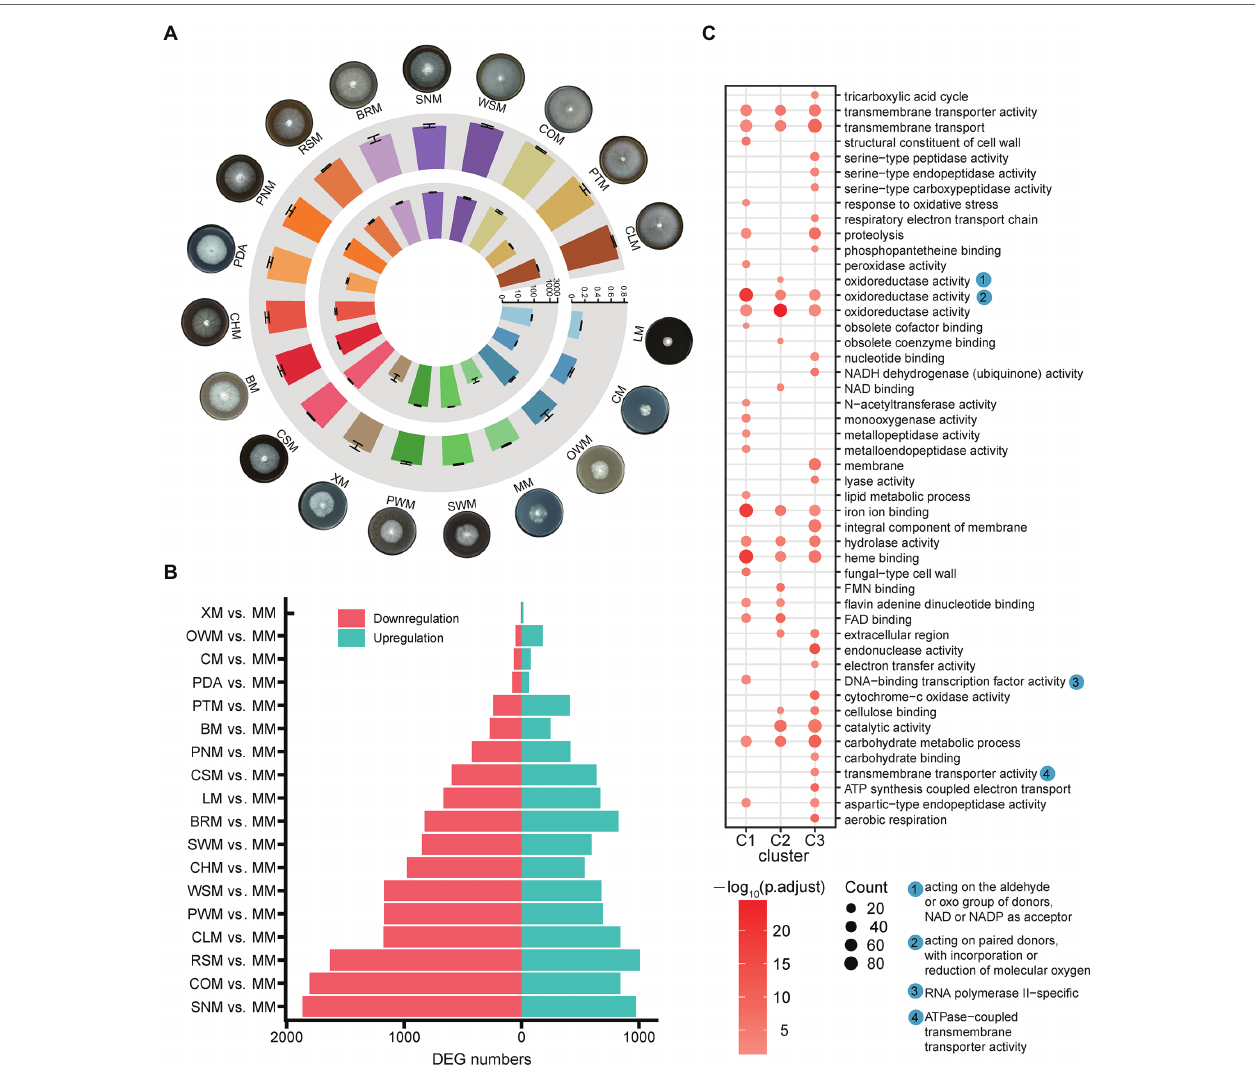
FIGURE 1 | Ganoderma lucidum mycelia cultured on different carbon sources and differentially expressed genes. (A) Growth status of mycelia (outer circle), growth rate of mycelia (middle circle, cm/d), and laccase activity of mycelia (inner circle, U/mg). (B) DEGs in the comparison of MM with all the other carbon sources. (C) Functional enrichment of DEGs. Glucose (MM), lignin (LM), cellulose (CM), xylan (XM), corncob (COM), cottonseed hull (CHM), wheat-straw (WSM), rice-straw (RSM), bran (BRM), pine wood sawdust (PWM), pine needle (PNM), spruce wood sawdust (SWM), spruce needle (SNM), pteridophyte (PTM), chestnut shell (CSM), chestnut leaf (CLM), bagasse (BM), oak wood sawdust (OWM), and potato dextrose agar